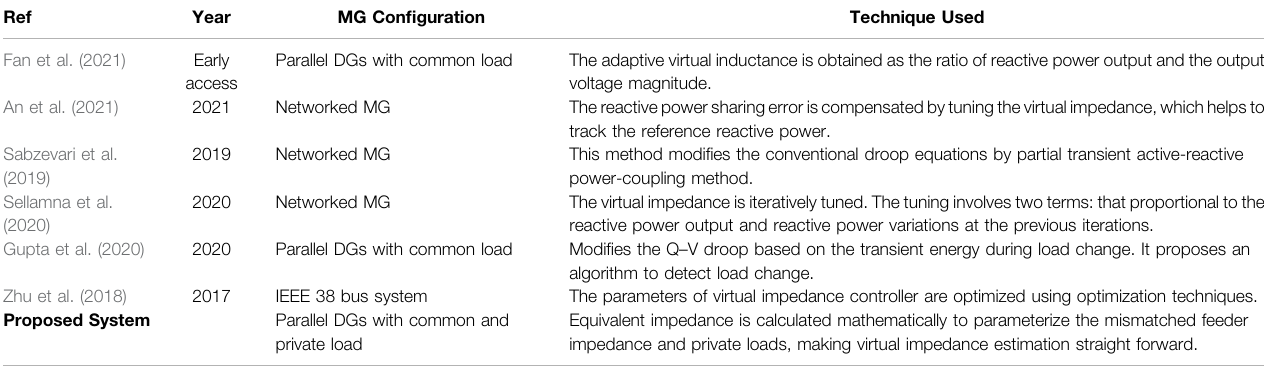
TABLE 1 | Summary of communciationless strategies in power sharing.